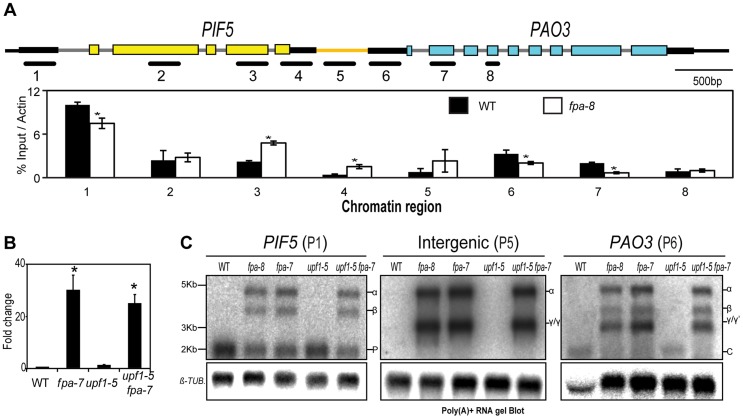

PIF5–PA03, an example of chimeric RNA formation controlled by FPA.(A) H3K4me3 Chromatin ImmunoPrecipitation (ChIP) analysis of genomic regions at the PIF5 locus. γ RNAs result from a shift in the transcription start site. Black lines depict the chromatin regions analysed by qPCR. Histograms show means ± SEM obtained for enrichment calculated by percentage input normalised against actin for three PCR amplifications. *, P<0.05; Student's t-test. (B) RT-qPCR analysis of PIF5–PA03 chimeric RNAs in fpa and upf1 mutants. Data are the means ± SEM obtained for three independent PCR amplifications of three biological replicates. The y-axis shows the fold change relative to wild-type (WT; (WT set to 1) after normalisation to UBC21 gene expression. Location of the RT-qPCR amplicon is displayed in Figure S7
D. *, P<0.05; Student's t-test. (C) RNA gel blot analysis of PIF5–PA03 chimeric RNAs in fpa and upf1 mutants.